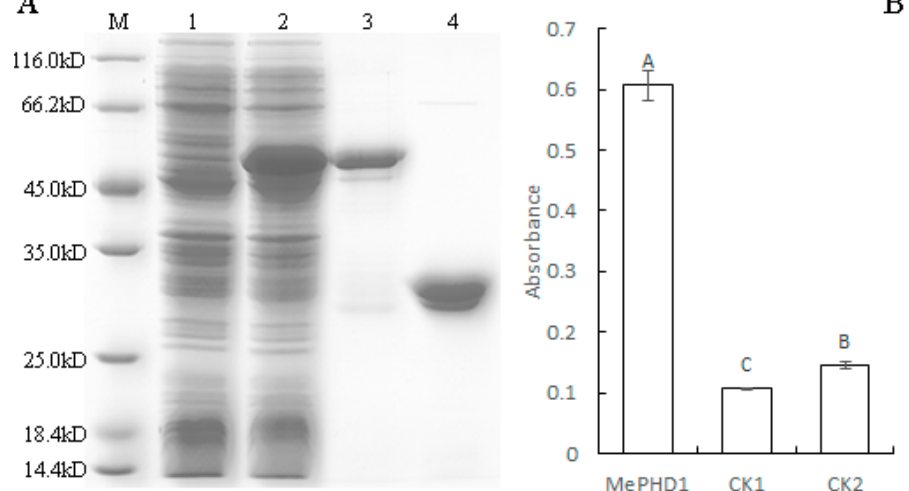
Figure 5. ( A ) MePHD1 binding to the promoter of MeAGPS1a, as analyzed DPI-ELISA. Over- expression of MePHD1 in Escherichia coli . M: Molecular markers; 1 represents the E. coli cells harboring pCold Pros2-MePHD1 not induced; 2 shows the E. coli cells harboring pCold Pros2-MePHD1, after 20 h of induction; 3 shows the purified MePHD1 fusion protein by the E. coli cells harboring pCold Pros2- MePHD1, after 20 h of induction; 4 shows the purified ProS2 tag protein, by the E. coli cells harboring pCold Pros2, after 20 h of induction. ( B ) MePHD1 interacts with the MeAGPS1a promoter by DPI- ELISA assay. MePHD1: Double-strand biotinylated MeAGPS1a promoter DNA probe + purified MePHD1 fusion protein; CK1: Double-strand biotinylated MeAGPS1a promoter DNA probe + tagged protein ProS2; CK2: Purified water + purified MePHD1 fusion protein. Error bars represent the SD of